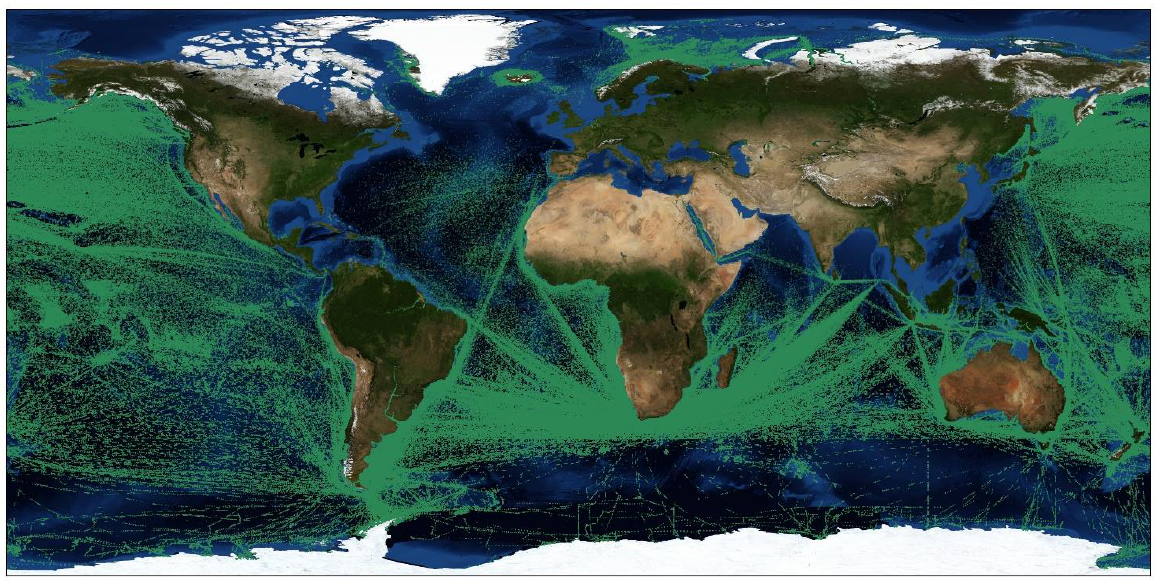
Figure 2. The chart drawn using part of the AIS data received by the HY-1C satellite.